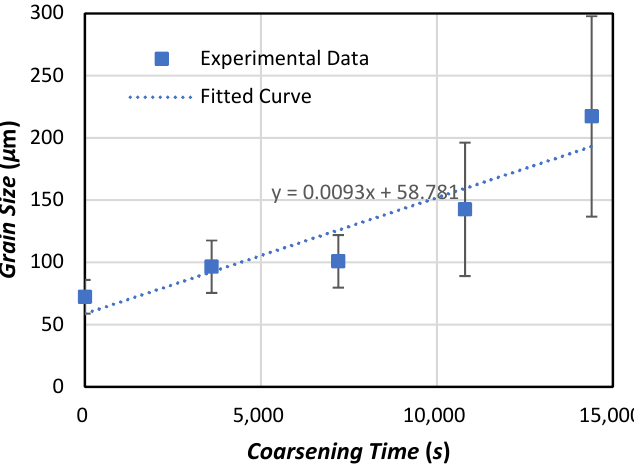
Figure 4. Relationship between dendrite arm size and times during isothermal coarsening of Al-4.5 wt.%Cu-2 wt.%TiB 2 alloy.